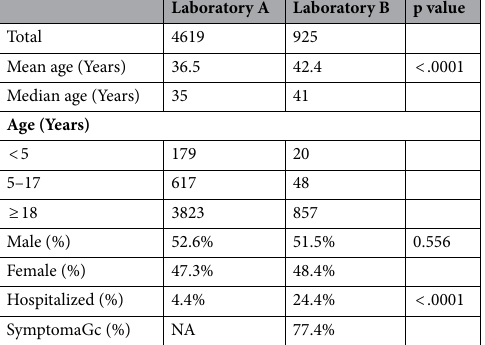
Table 1. Characteristics of study population. Baseline characteristics of study population for Laboratory A and B. P values calculated by two tailed t-test (Median Age) and Fischer’s Exact test (sex, hospitalization) are shown. P values less than 0.05 are considered significant.